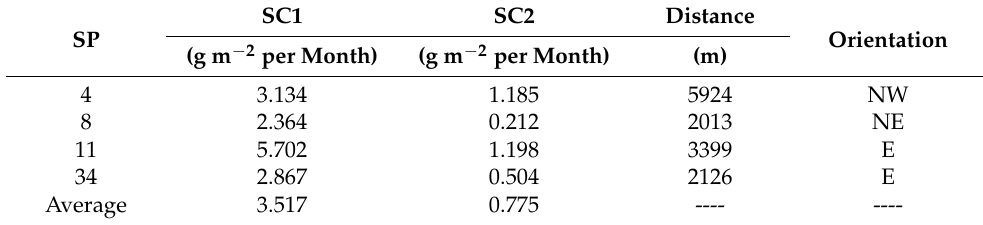
Table 3. Dust fallout in selected sampling points within the 6 km sampling area.